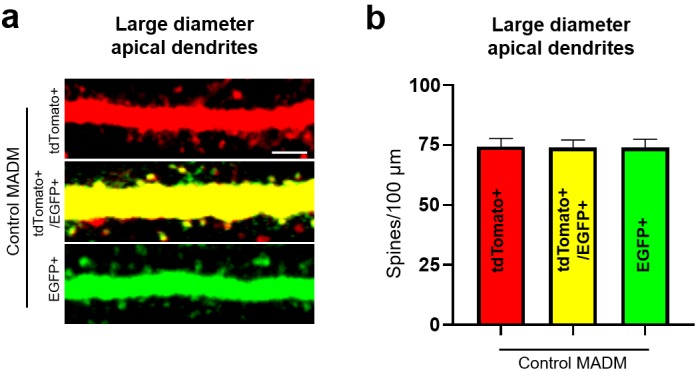
Equal spine density in control MADM neurons regardless of fluorophore expressed.(a) Representative large diameter (>1.6 μm) dendrites of subgranular pyramidal neurons in control Nestin-spCre MADM mice. Scale bar, 3 μm. (b) Quantification of spine density on large diameter dendrites from neurons in control MADM mice (tdTomato + neurons, n = 38 neurons, five animals; EGFP + neurons, five animals n = 39; tdTomato+/EGFP + neurons, n = 16, two animals; F(2, 90)=0.003162, p=0.9968, one-way ANOVA).10.7554/eLife.41563.024Figure 6—figure supplement 1—source data 1.Spine density WT MADM neurons.